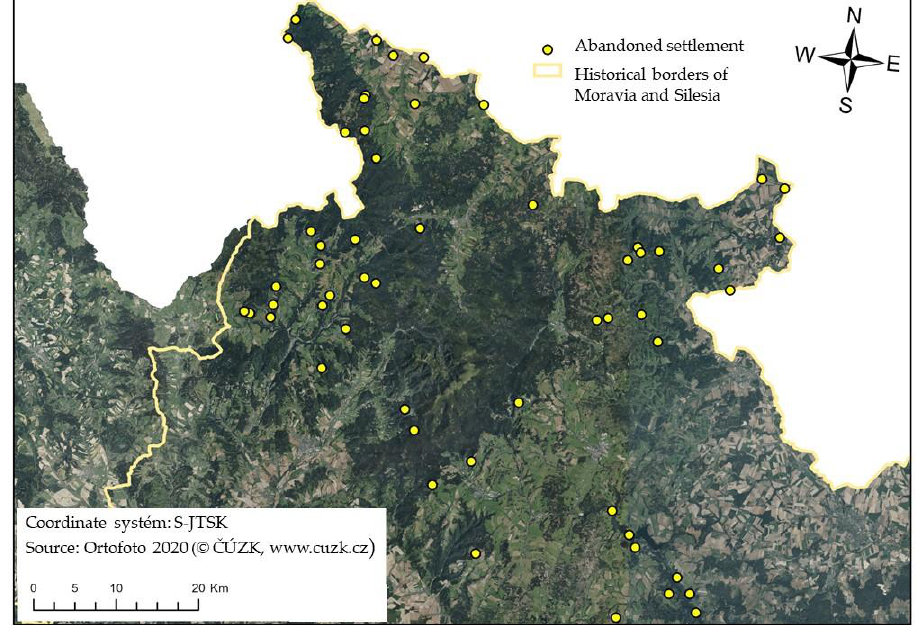
Figure 2. Delimitation of the addressed territory in a detailed view.